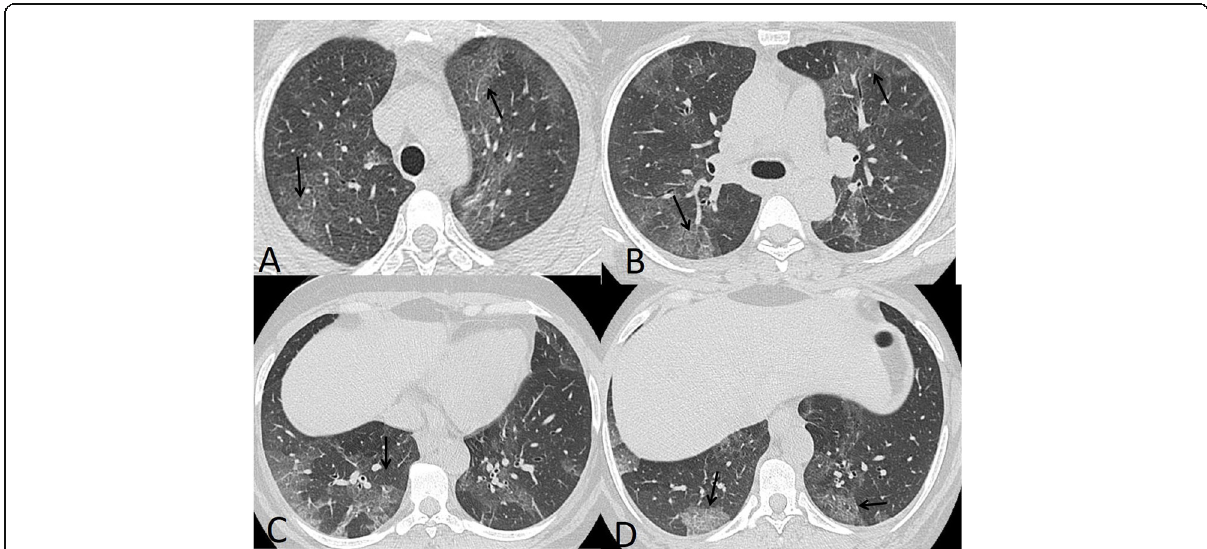
Fig. 7 A 53-year-old female with mild involvement of the both upper lobes (arrows in a and b ) and middle lobe (not shown) and moderate involvement of both lower lobes with peripheral subpleural patchy ground glass opacities (arrows in c and d ). Total severity score = 12